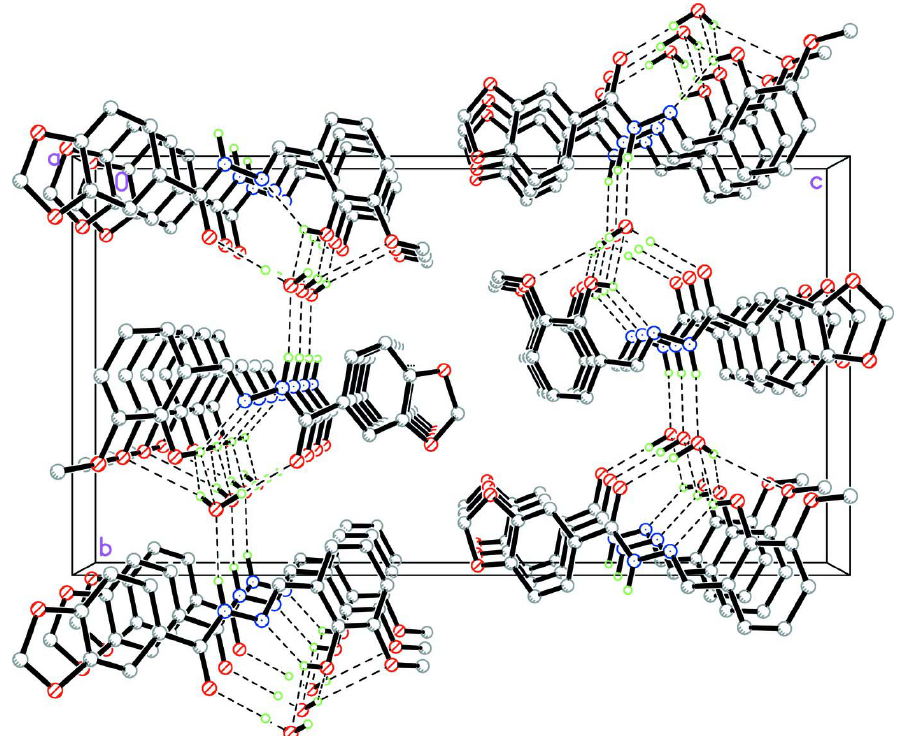
Figure 2 The crystal packing of the title compound, viewed down the a